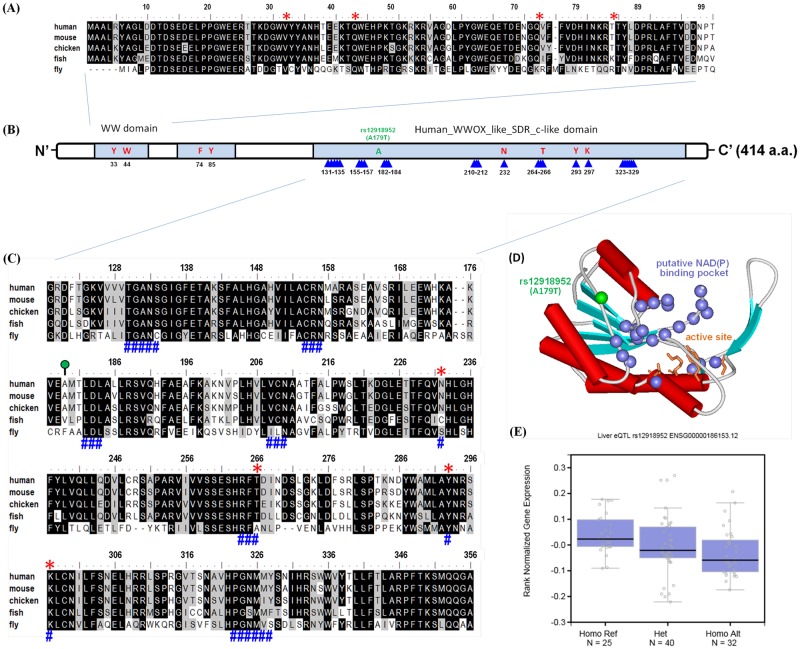
Structural characterization and SNP (rs12918952) in human WWOX protein (NP_057457.1).Alignments of conserved domain-based sequences of (A) two conserved tryptophans domain (WW; cd00201) and (C) classical-like SDR domain (human_WWOX-like_SDR_c-like; cd09809) by use of multiple sequence alignment format and numbered according to the human WWOX is shown above the sequences. Strick consensus amino acids in the putative active centers of compact structural units are shown: the key amino acids of active site and cofactor binding site are highlighted in red star and blue pound signs, respectively. The WWOX-relative sequences are as follows: human (H. sapiens, NP_057457.1); mouse (M. musculus, NP_062519.2); chicken (G. gallus, NP_001025745.1); fish (D. rerio, NP_957207.1) and fly (D. melanogaster, NP_609171.1). (B) Schematic representation of the overall human WWOX protein; domain symbols are drawn approximately to scale. The rectangle represents the WW and human_WWOX-like_SDR_c-like domain; the key residues of active site and cofactor binding site are highlighted in red and triangle sign, respectively. The N-terminal and C-terminal ends are indicated (N’ and C’, respectively). (D) Ribbon diagram showing the homologous 3D model of the SDR_c-like domain of human WWOX using the SWISSMODEL server based on M. abscessus short chain dehydrogenase or reductase crystal structure (PDB ID: 3RIH). The side chains of the amino acids characterized catalytic tetrad of Asn232-Thr266-Tyr293-Lys297 are shown as sticks and labeled which aligned well with the ‘classical’ type of short-chain dehydrogenase/reductase (SDR) enzyme. The blue spheres represent the putative coenzyme NAD (P)-binding pocket is drawn to illustrate the location of the cofactor binding site. The ribbons indicate the backbone course of human WWOX and the arrows represent b-strands, and cylinders indicate a-helices. The figure was prepared using ViewerLite™ 5.0 software. (E) Expression quantitative trait locus association between rs12918952 genotype and WWOX expression in whole blood (GTEx data set). Numbers in parentheses indicate the number of cases.